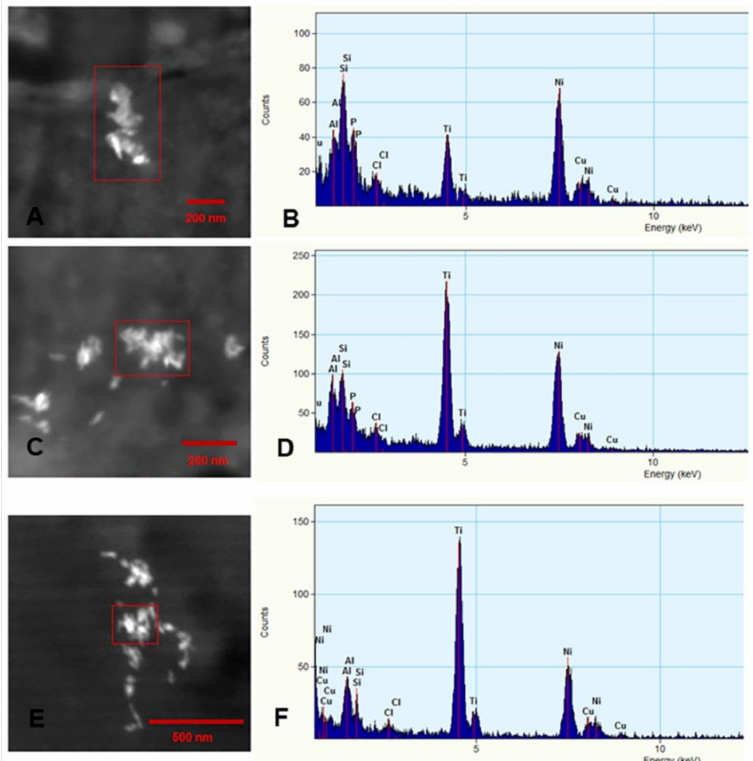
Figure 8. Representative nanoparticles with EDX elemental maps from term and early placenta and brain PCW 12 samples. Panels ( A , B ): term placenta shows an agglomerate of NPs containing titanium (ranging from 10 to 100 nm) co-occurring with silicon and aluminum. Panels ( C , D ): early placenta at PCW 12 with an agglomerate of titanium, silicon and aluminum. Panels ( E , F ): brain samples at PCW 12 with titanium, aluminum, and silicon. Ni grids were used.